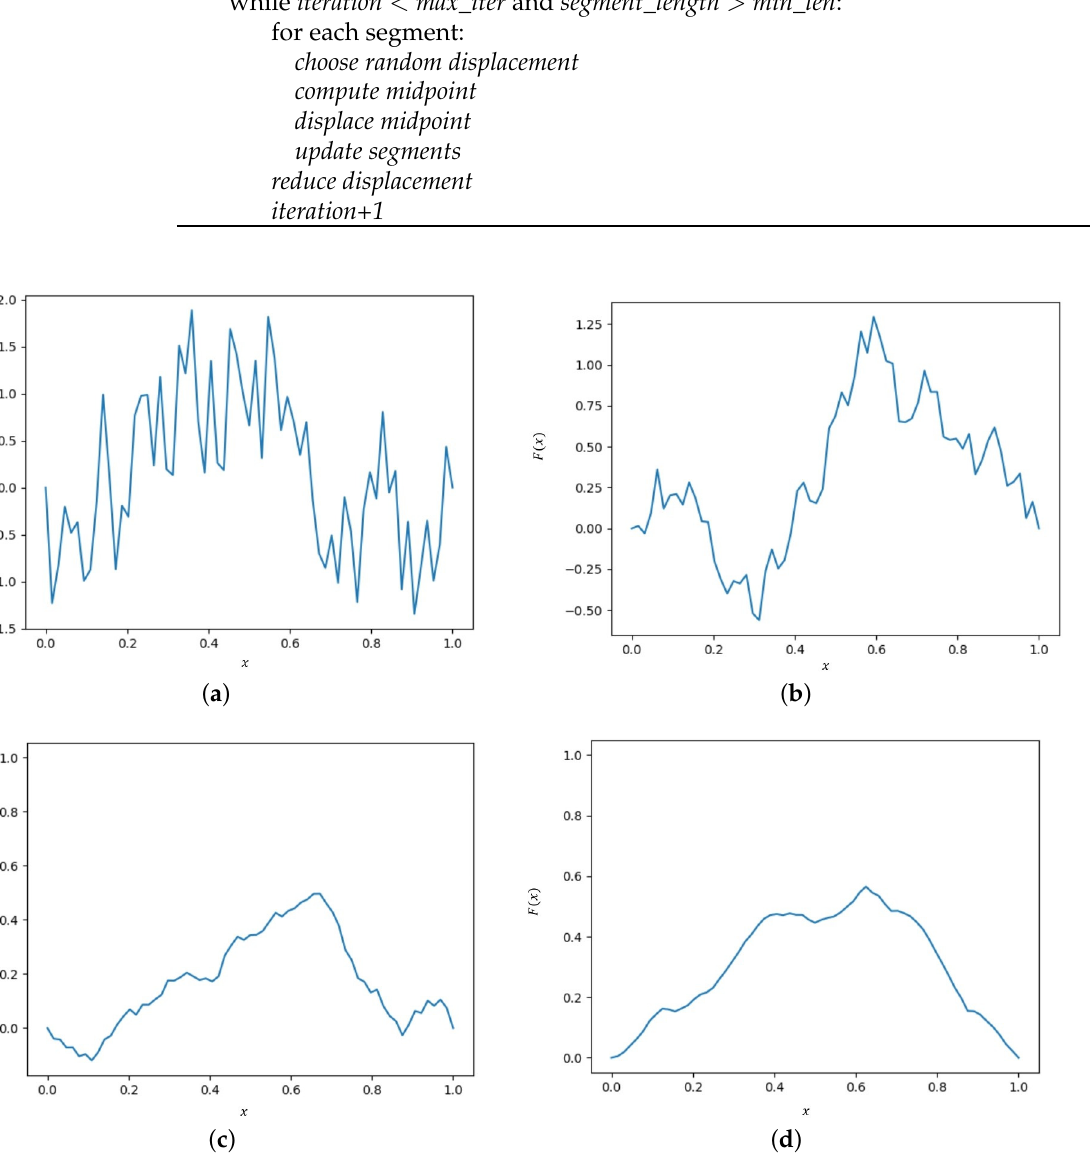
Figure 8. One-dimensional (1 D ) landscapes for ( a ) H = 0.0, ( b ) H = 0.25, ( c ) H = 0.50, and ( d ) H =